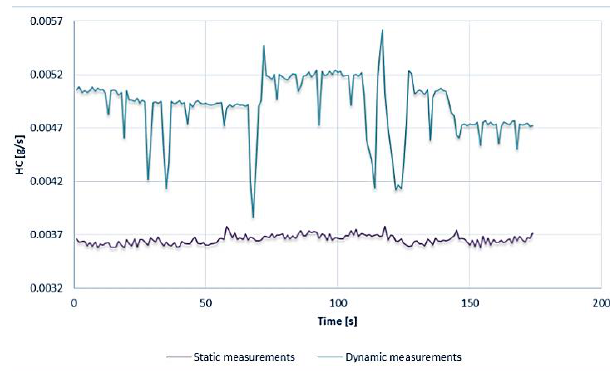
Fig. 6. The dependence of HC [g/s] emission under test conditions It also provides information about real fuel consumption using the carbon balance method according to the following formula: [(0.866 ∙ HC) + (0.429 ∙ CO) + (0.273 ∙ CO FC w = 0.1155 ρ fuel